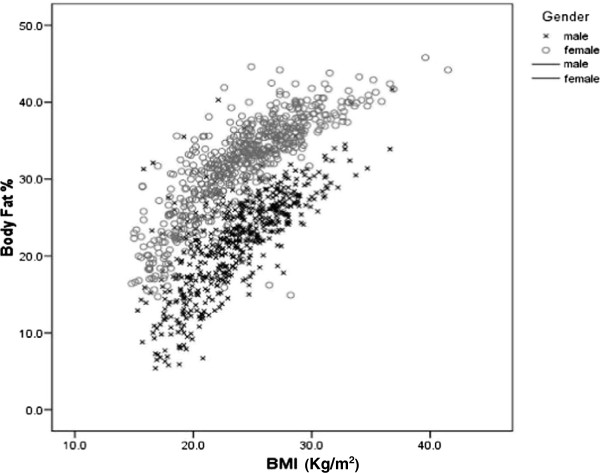
Scatter plot of the relationship between Body Mass Index (BMI) and percentage of body fat (BF%) of Sri Lankan men (+) and women (o). Relationship between the percentage of body fat (BF %) and body mass index (BMI) of Sri Lankan (+) males and (o) females. The linear regression models: (BF% male = (BMI × 1.114) + (age × 0.139) – 9.662 and BF% female = (BMI × 0.918) + (age × 0.153) +3.819.Polynomial regression for non linearity: females (R2 = 0.70, SEE 3.4%, p < 0.000) males (R2 = 0.58, SEE 4.1%, p < 0.05).